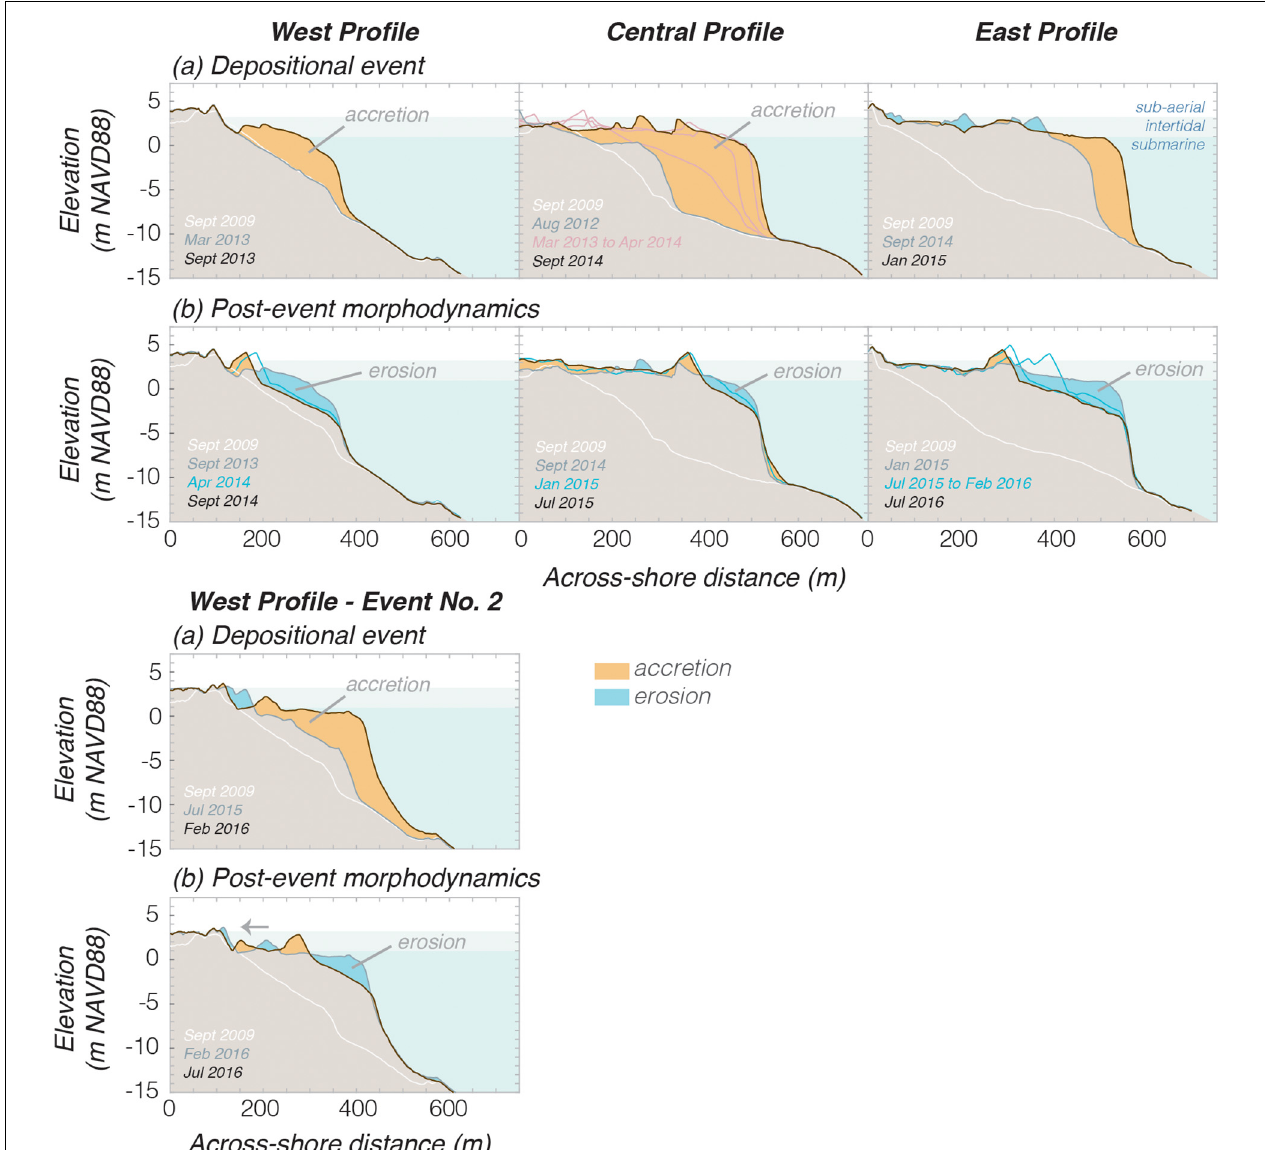
FIGURE 4 | Topographic and bathymetric profiles through the axis of several depositional events at the mouth of the Elwha River, Washington. Four distinct events were observed with time as the river location changed and the river sediment discharge rates varied with time. This resulted in coincidental morphologic evolution for many of these profiles. Profiles highlight (a) before and immediately after deposition events, and (b) the post-deposition changes for the three cross-shore profiles shown in Figure 2 . Areas of accretion and erosion are highlighted with shading